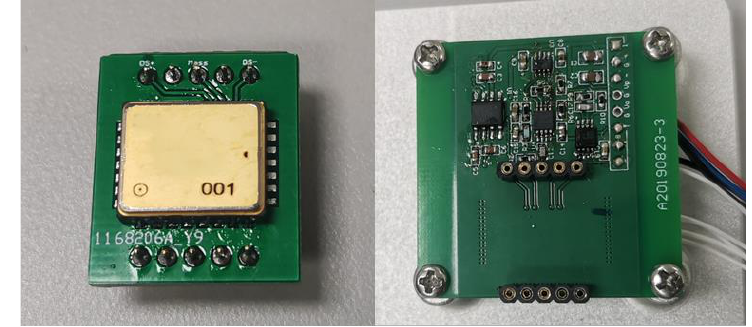
Figure 5. Experimental sample and measurement board.